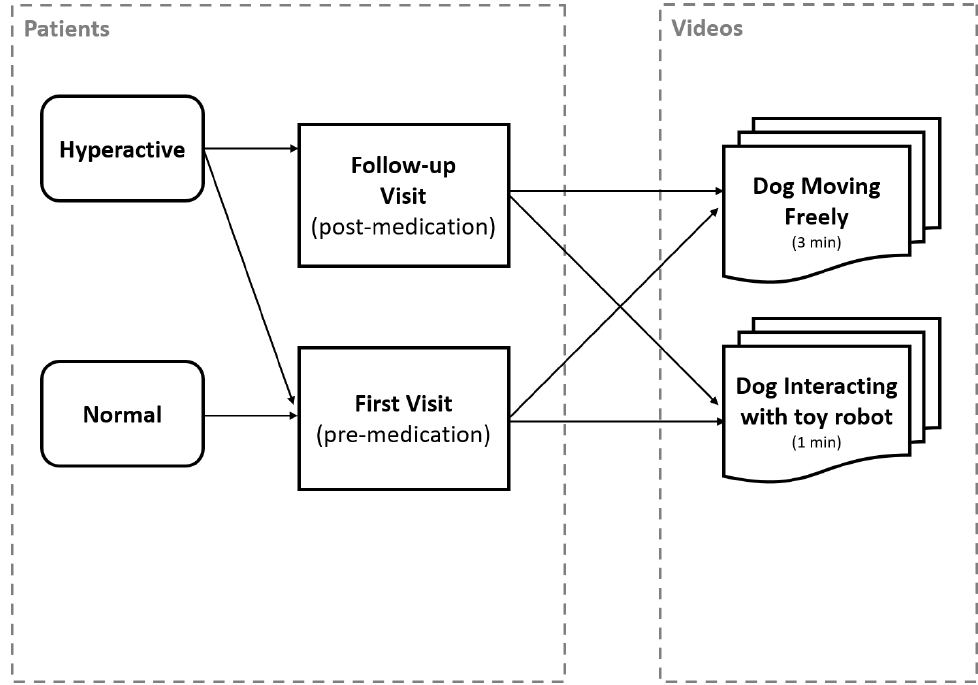
Figure 1. Data collection